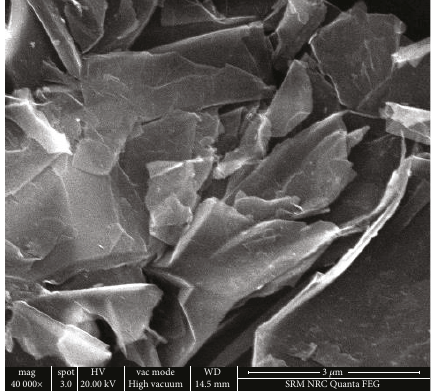
Figure 1: SEM image of the graphene platelet